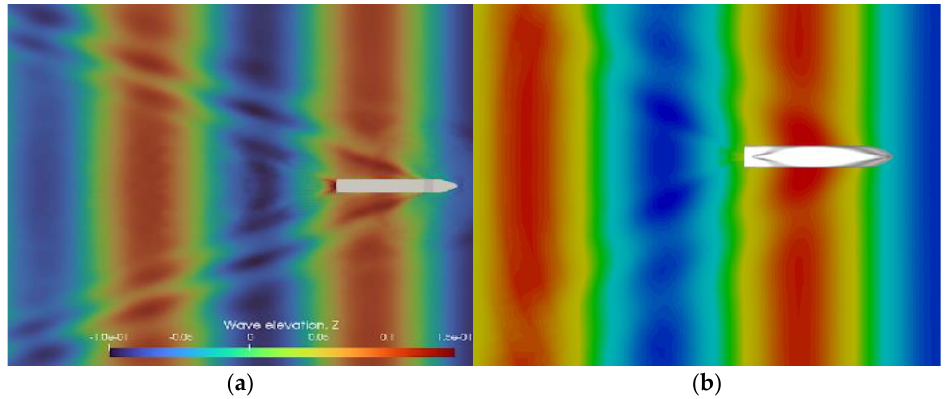
Figure 33. Top view snapshots from the simulations for case 3 of the KRISO containership: ( a ) OpenFOAM; ( b ) Wasim.